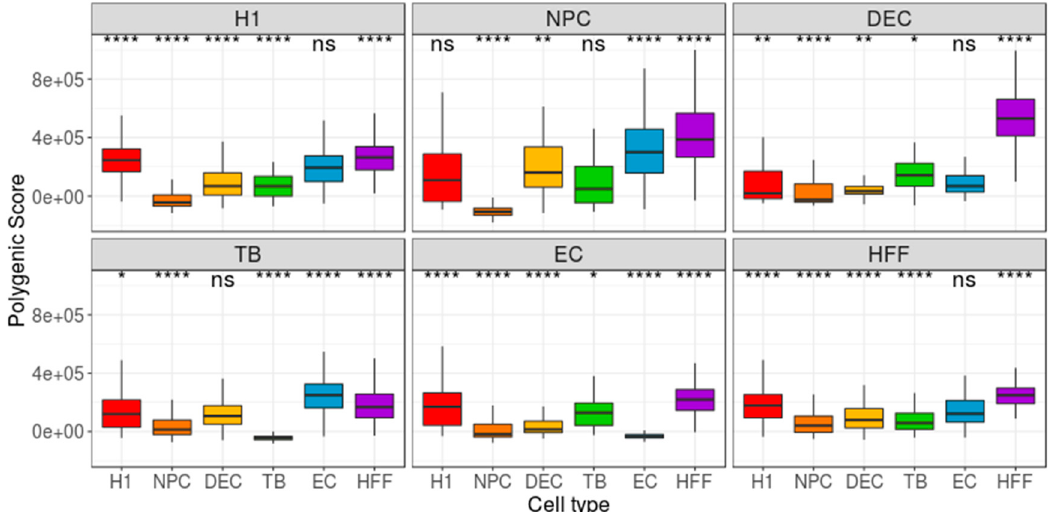
Figure 4. Distribution of group-based, cell-centered mean-expression (mean-EXP) scores, calculated across the 200 genes that were found to have the lowest gene-centered mean-EXP scores. The 200 genes with the lowest mean-EXP score values were detected separately for each cell type, and then cell-centered mean-EXP scores were calculated, based on these genes. Panel titles indicate the focus groups. H1: human embryonic stem cells ( n = 375 cells); NPC: neural progenitor cells ( n = 173 cells); DEP: definitive endoderm progenitors ( n = 138 cells); EC: endothelial cells ( n = 105 cells); TB: trophoblasts ( n = 69 cells); HFF: human foreskin fibroblasts ( n = 159 cells). Each group was compared to all other cell types, combined, using a Wilcoxon test. Ns: non-significant ( p > 0.05), * p ≤ 0.05, ** p ≤ 0.01, *** p ≤ 0.001, **** p ≤ 0.0001.